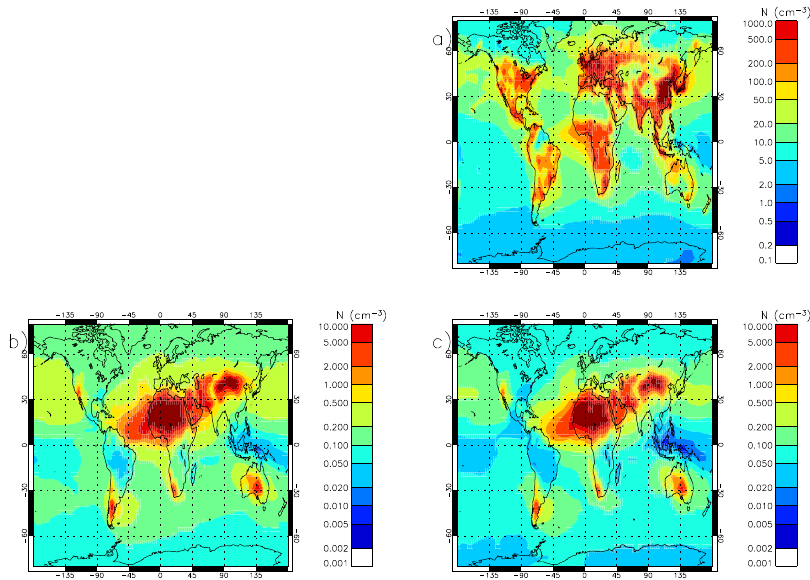
Fig. 11. Global maps of simulated annual-mean particle number concentration in the lowest model level for (a) Aitken-insoluble mode, (b) accumulation-insoluble mode and (c) coarse-insoluble mode.